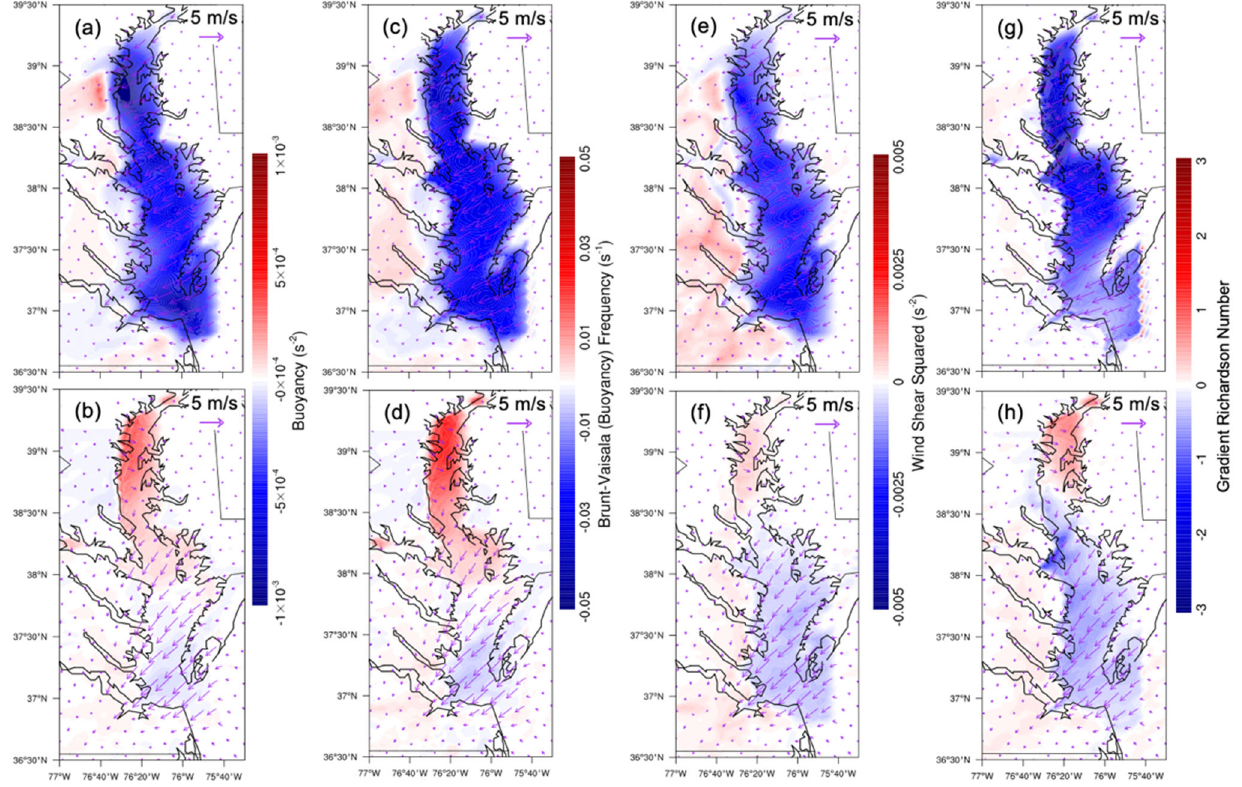
Figure 11. Differences (water minus nowater) in WRF–Chem-simulated variables related to stability during both nighttime (first row) and daytime (second row). ( a , b ) Buoyancy. ( c , d ) Brunt–Väisälä (buoyancy) frequency. ( e , f ) Wind shear squared. ( g , h ) Gradient Richardson number. The overlaid streamline is the corresponding surface wind difference. Daytime is defined as 1000–0000 UTC (or 06:00–20:00 local time); nighttime is defined as 0000–0900 UTC (or 00:00–06:00 and 20:00–00:00 local time).